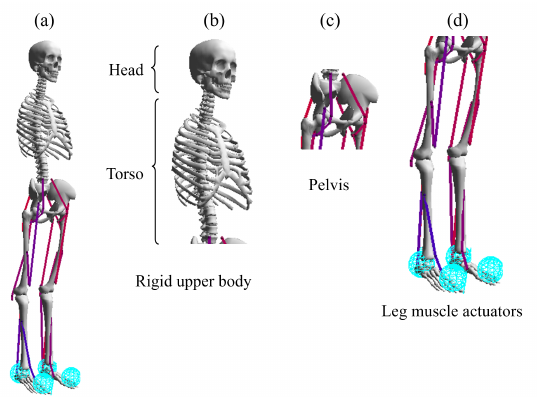
Figure 1. The body sections of the musculoskeletal ( a ), which consist of one upper body segment ( b ), a pelvis ( c ), and several segments for legs ( d